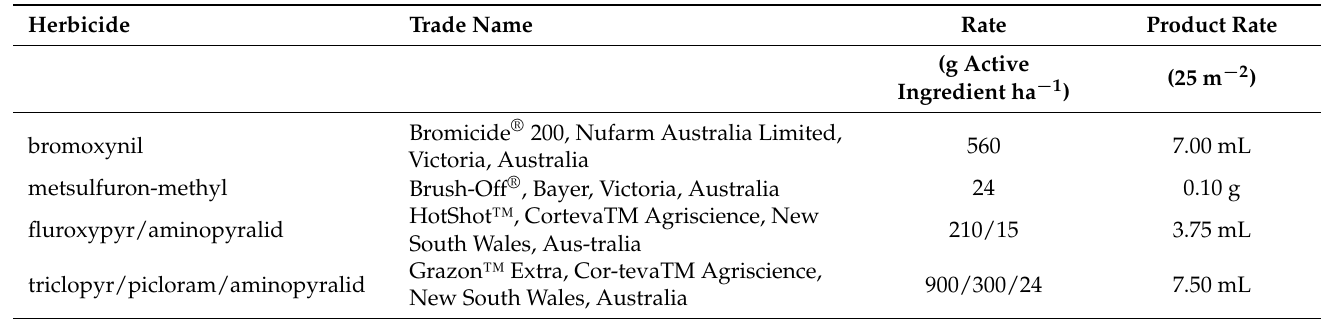
Table 5. Herbicide treatments, trade names, and rates applied to control fireweed. All